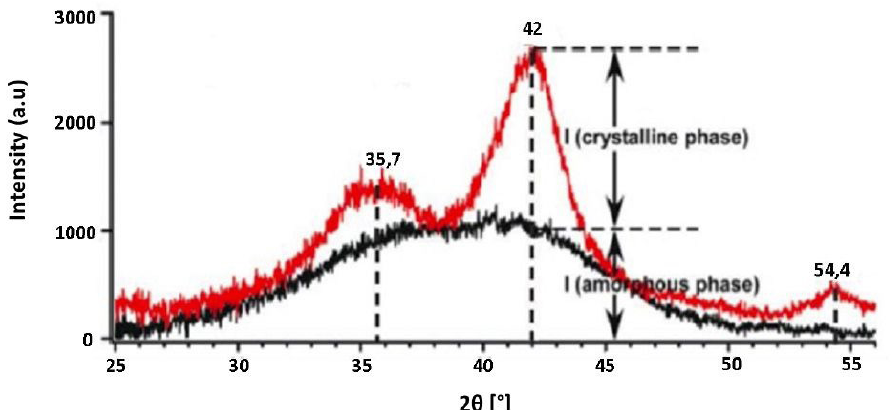
Figure 13: Diffraction profile of a hypothetical sample, crystalline phase and amorphous